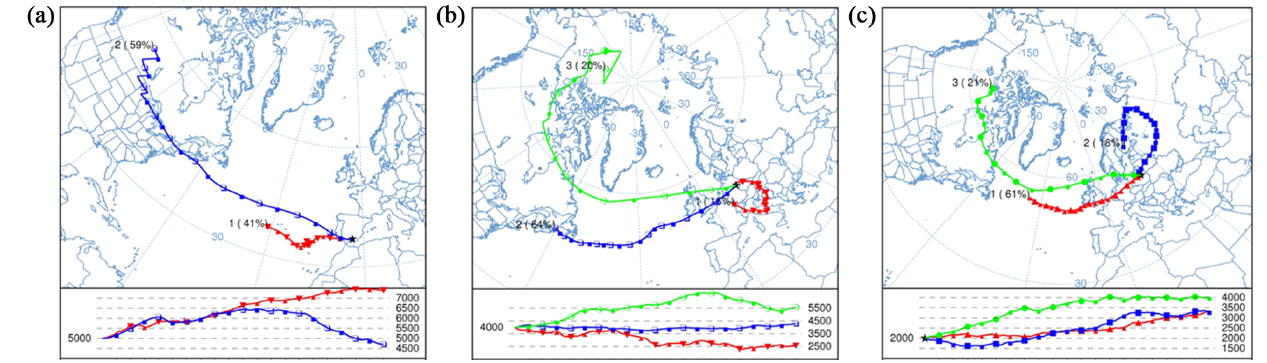
Figure 2. Coordinates and altitude in meters above ground level (black lines) of the 10-day backward-trajectories clusters during the period June–July 2013 arriving at Granada (a) , Leipzig (b) and Warsaw (c) .